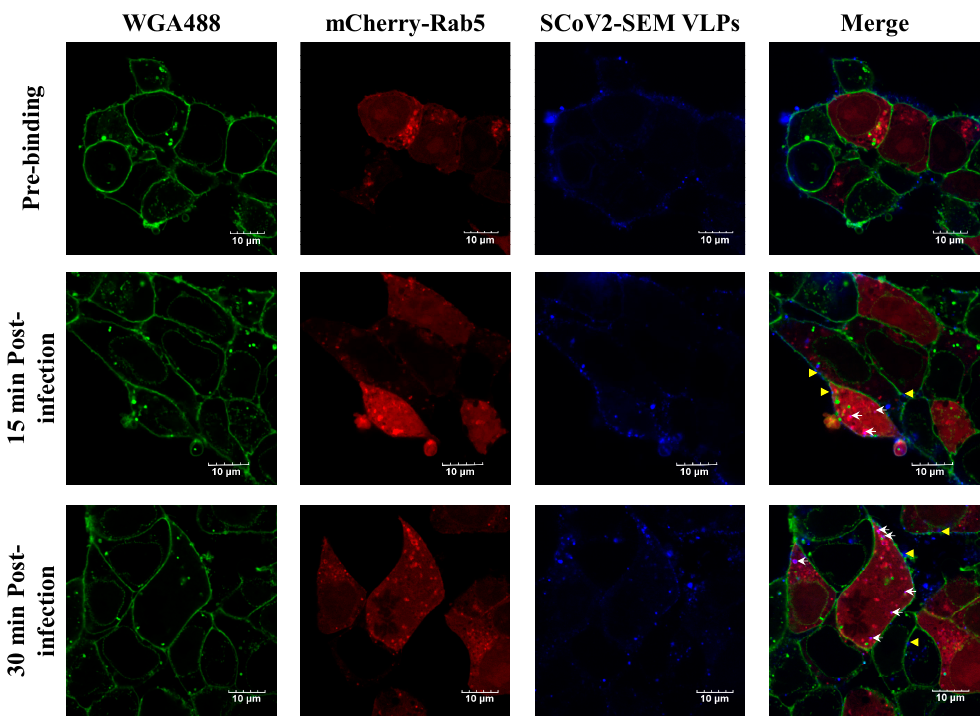
Figure 5. The visualization of Atto647N-tagged SCoV2-SEM VLP infection in HEK293T-ACE2 cells. HEK293T-ACE2 cells were incubated with Atto647N-tagged SCoV2-SEM VLPs at 4 °C for 30 min, considered as viral pre-binding, and the temperature was switched to 37 °C, considered as viral infection, for time indicated. Cellular membrane stained with WGA488 was shown in green, mCherry-Rab5-indicated early endosome was shown in red, and Atto647N-tagged SCoV2-SEM VLPs were depicted in blue. White arrows indicated that SCoV2-SEM VLPs were co-localized with early endosomes. Yellow arrows indicated that SCoV2-SEM VLPs were fused with cell membrane. Scale bar, 10 μ m.